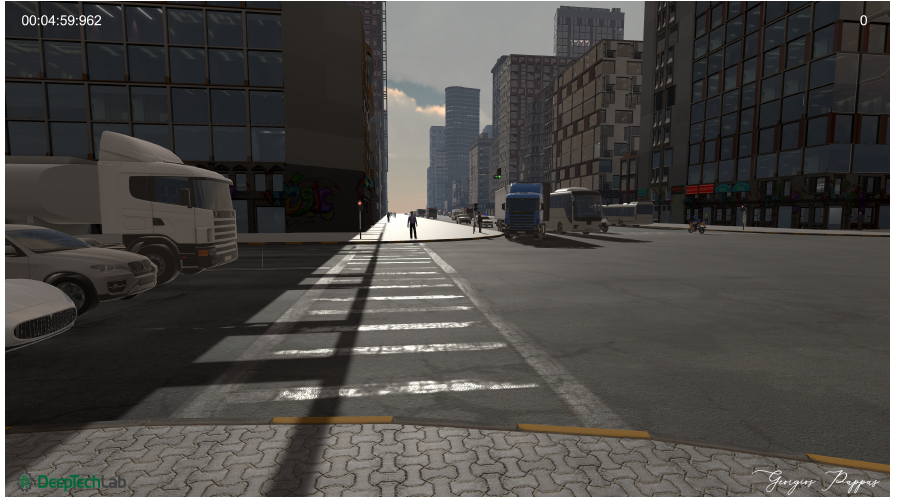
Figure 8. The main menu helps the participants to switch between the various scenarios of the tool.